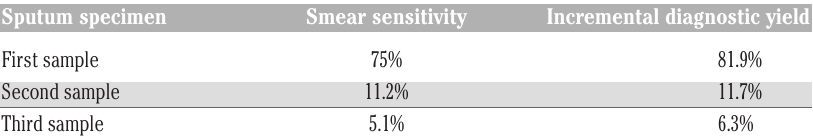
Table 1. Diagnostic yield of acid fast bacilli smear examination among pulmonary tuber- culosis cases co infected with